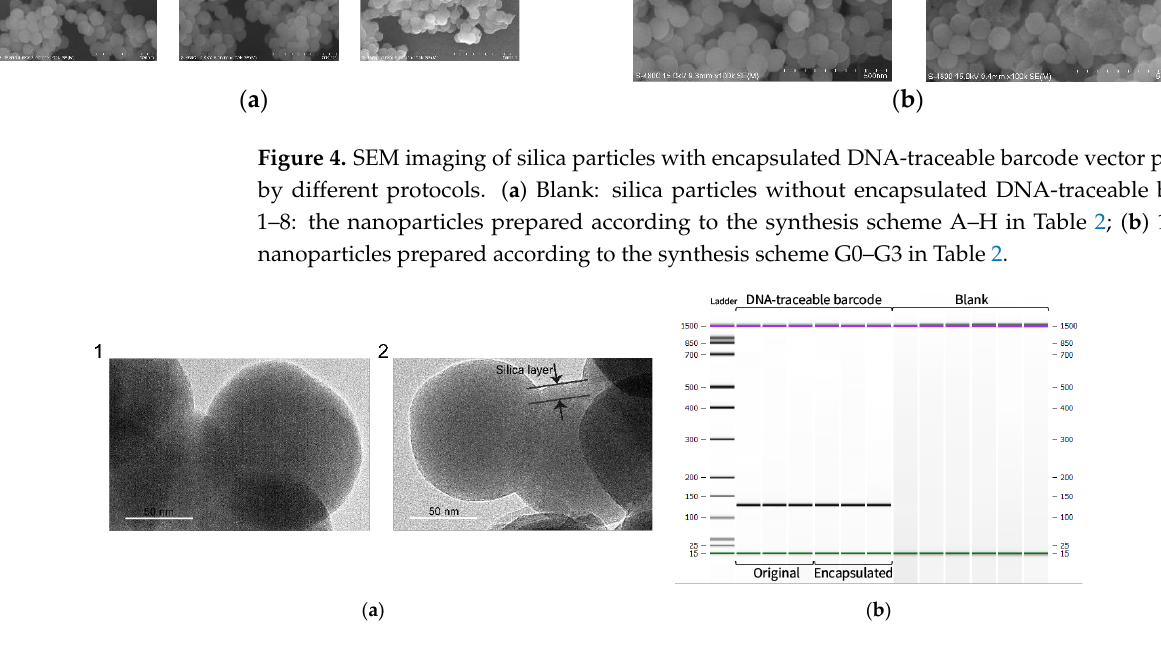
Figure 4. SEM imaging of silica particles with encapsulated DNA-traceable barcode vector prepared by different protocols. ( a ) Blank: silica particles without encapsulated DNA-traceable barcode; 1 – 8: